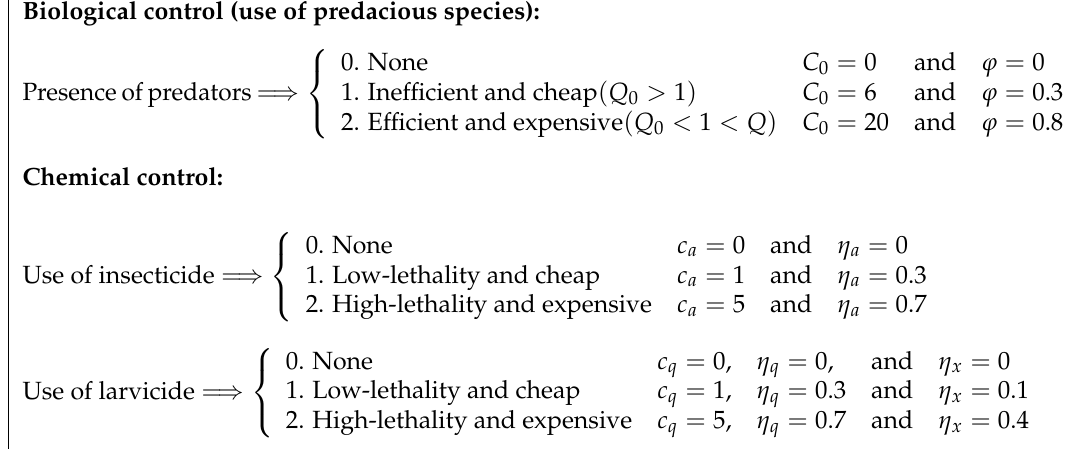
Figure 2. Description of scenarios with parameter values corresponding to different strategies of biological and chemical control actions.